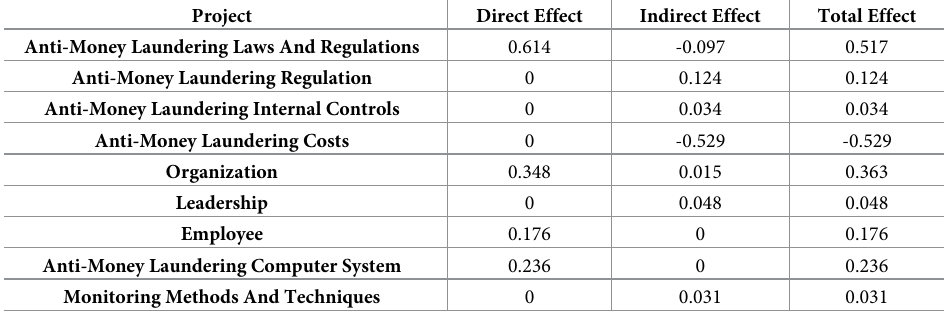
Table 5. List of calculation results of the effects of various factors on the effectiveness of commercial banks’ anti- money laundering.